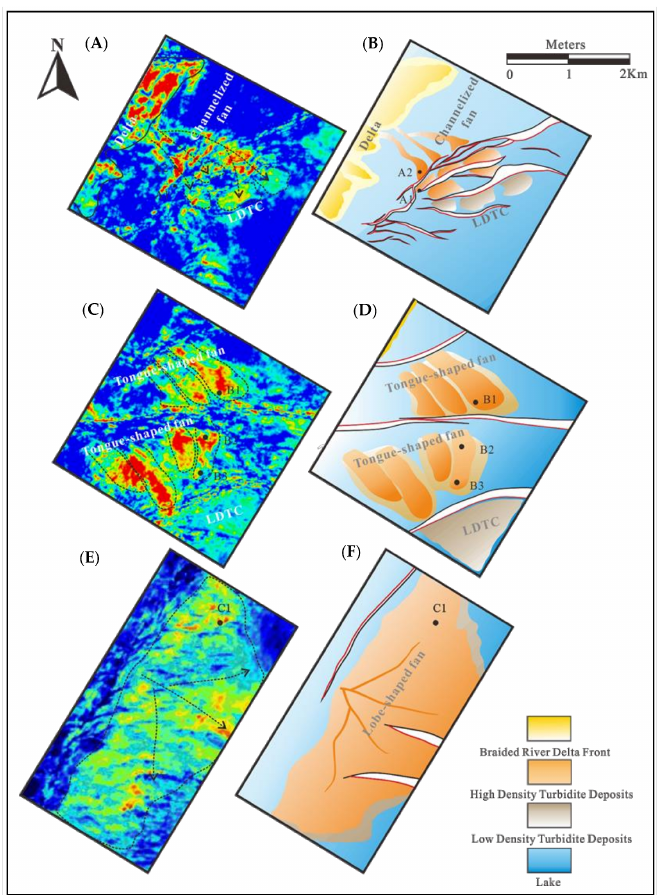
Figure 12. Plane distribution of RMS amplitude and sedimentary facies (Figure 1C shows locations). ( A ) Plane distribution of RMS in the region A (HST). ( B ) Plane distribution of sedimentary facies in the region A (HST). ( C ) Plane distribution of RMS in the region B (TST). ( D ) Plane distribution of sedimentary facies in the region B (TST). ( E ) Plane distribution of RMS in the region C (TST). ( F ) Plane distribution of sedimentary facies in the region C